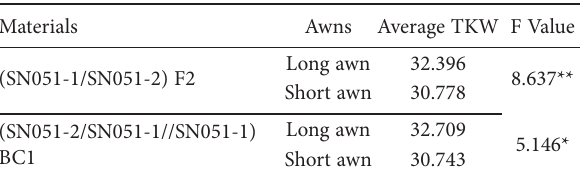
Table 2. the thousand seed weight of long awn plants and short awn